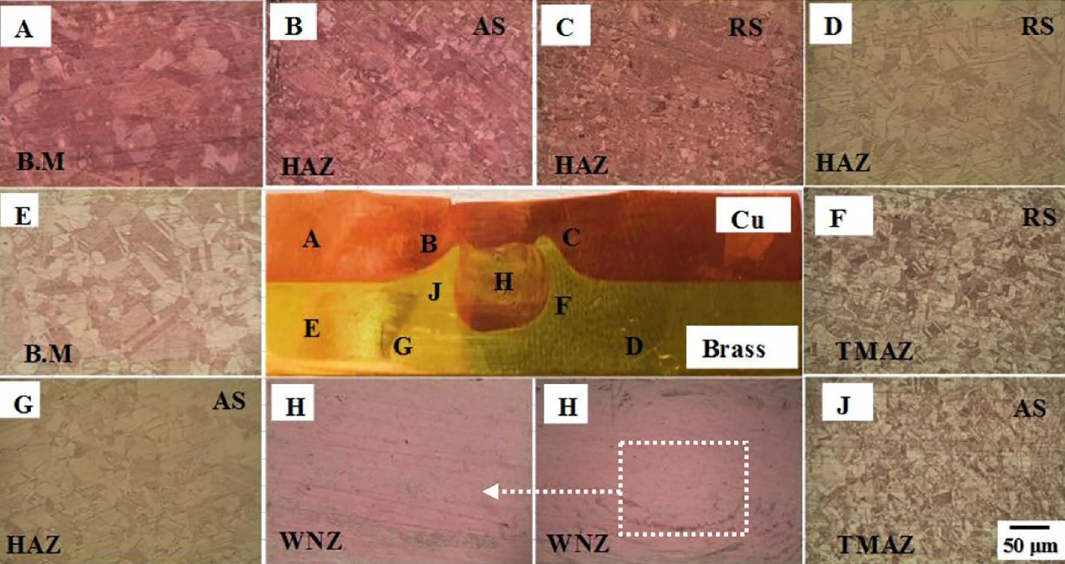
Figure 10. Optical macrostructure and microstructure of different weld zone in case B with the welding condition of 710 rpm and 16 mm/min. respectively. Through-nugget fracture was not